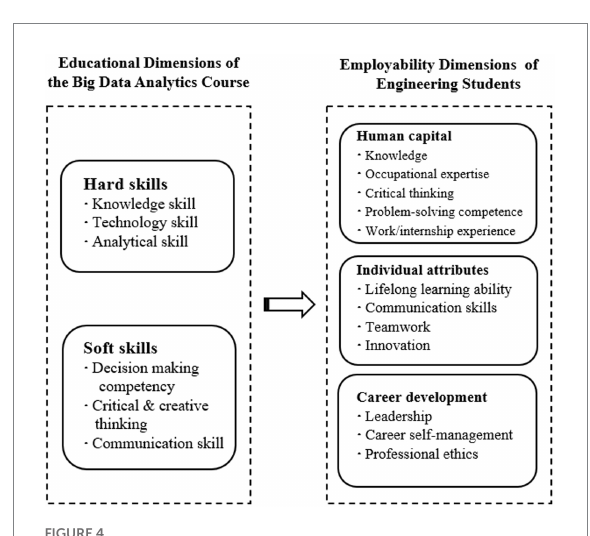
FIGURE 4 Educational dimensions of the BDA course and employability dimensions of engineering